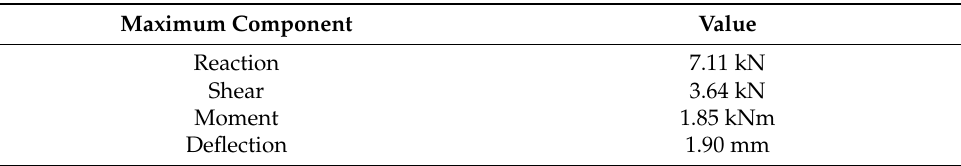
Figure A11. Cantilever joists ( a ) shear force diagram, ( b ) bending moment diagram, and ( c ) deflection diagram over the joist length in m. Table A4. Cantilevered system joist load table for a design load of 2.27 kPa.